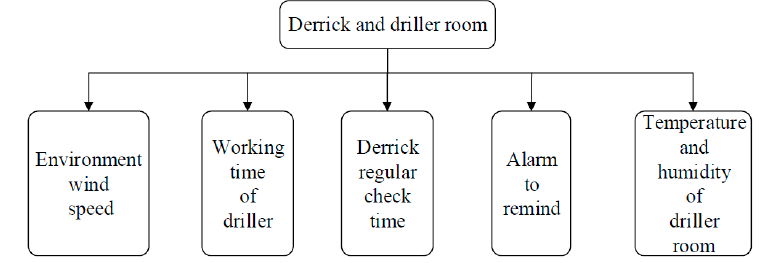
Figure 5. Parameters of derrick and driller room. Table 2. Parameters of type ‘A’ derrick.